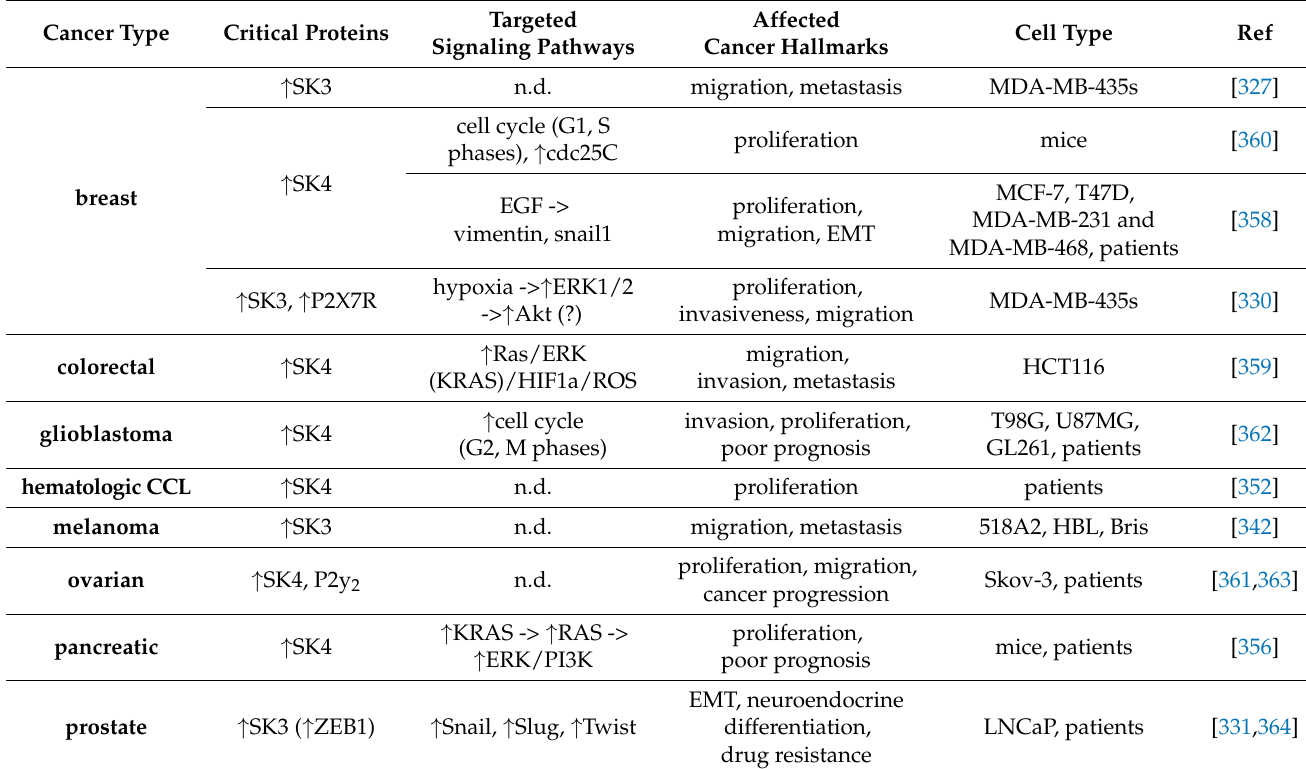
Table 2. Correlation of cancer types with critical SK